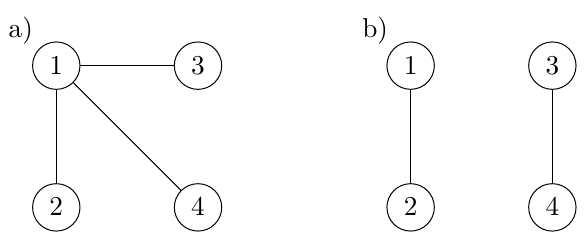
Figure 58. Graphs associated to (a) | 0 i and (b) | + x i as graph